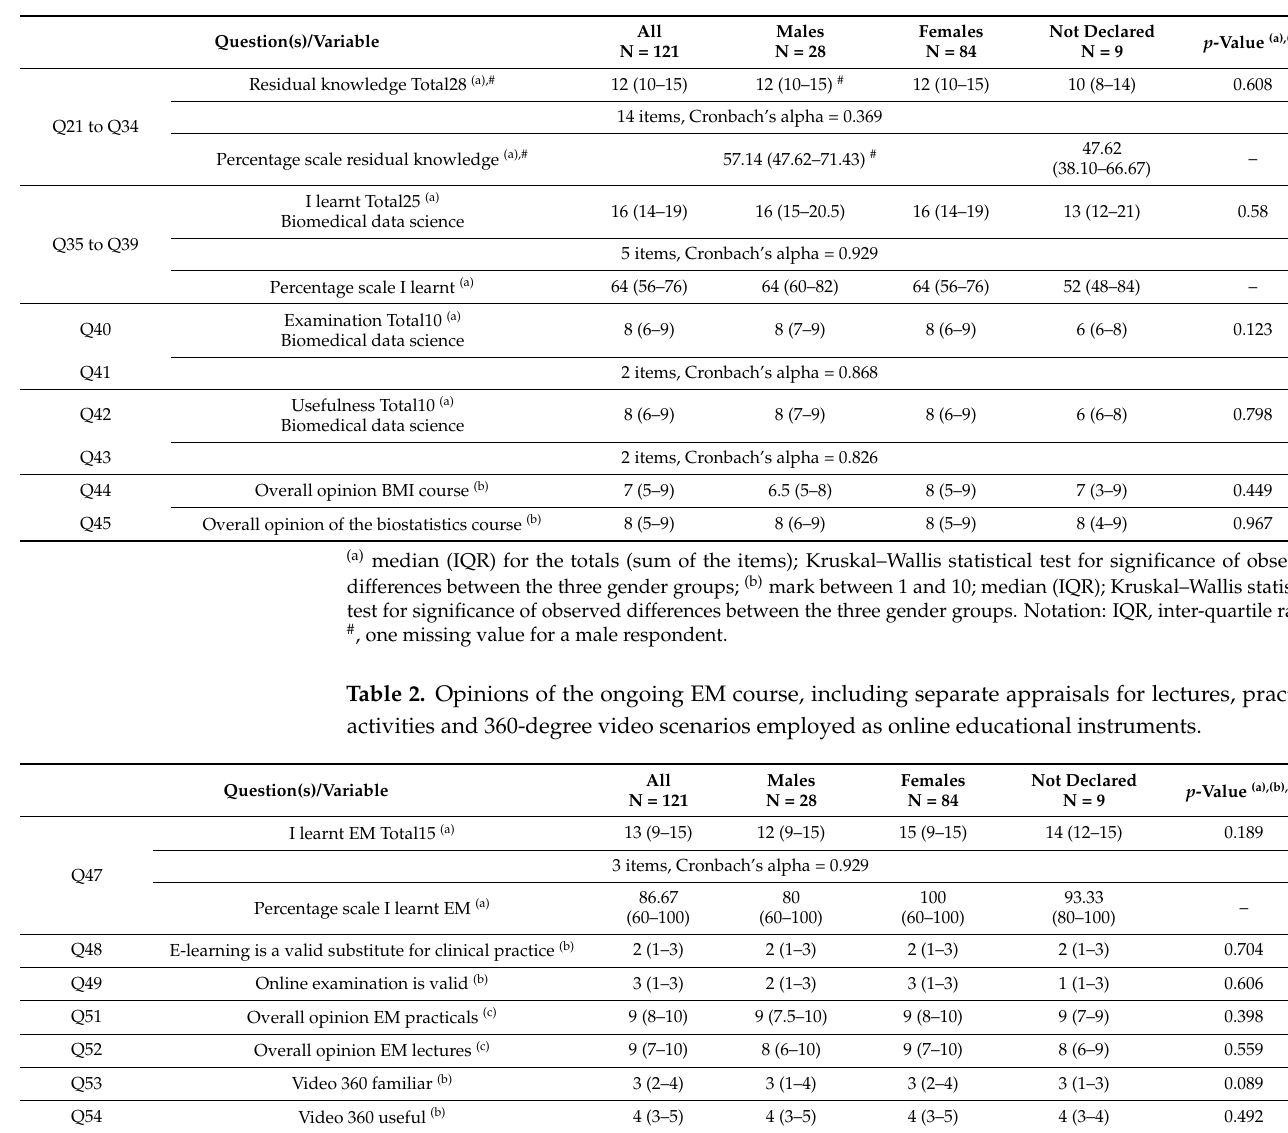
Table 1. Measured residual and self-assessed knowledge of BMI and biostatistics and students’ opinions of the two courses (including examinations, perceived usefulness and overall appraisal for each).